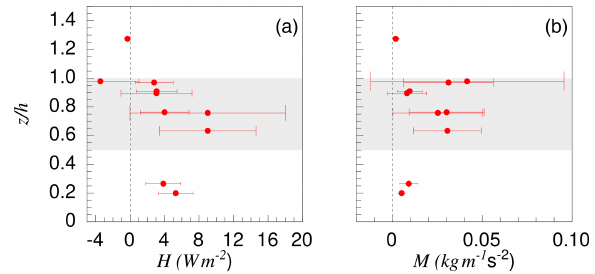
Figure A2. (a) Fluxes of sensible heat and of absolute values of mo- mentum as measured on 5 June 2017. Whiskers in both panels show the sampling error (cid:15) , determined following Friehe et al. (1991).